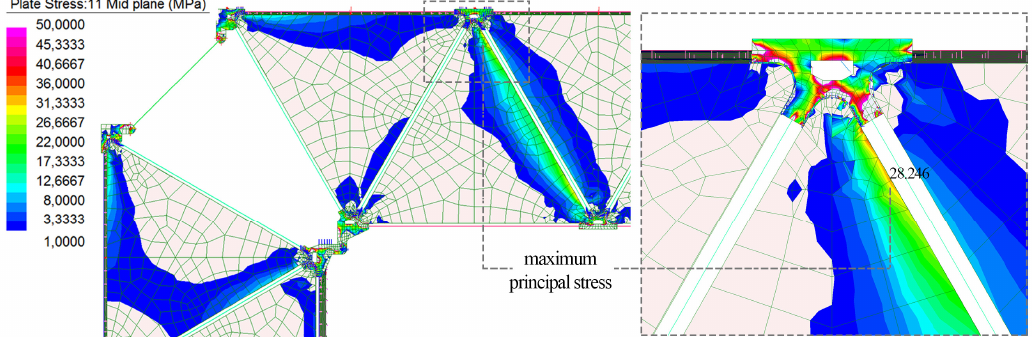
Figure 15. ULS non ‐ linear static analysis and comparison between FM TVT γ‐ bis (first row) and CFM TVT γ‐ bis (second row): ( a, c ) maximum principal stress; ( b, d ) minimum principal stress.